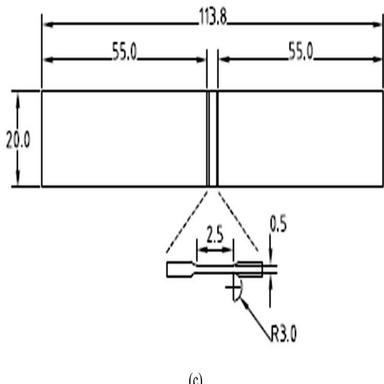
Ductile fracture test specimens in shear dominant zone and forming limit diagram (FLD) zone: (a) pure shear, (b) uniaxial tension, and (c) plane strain tension.